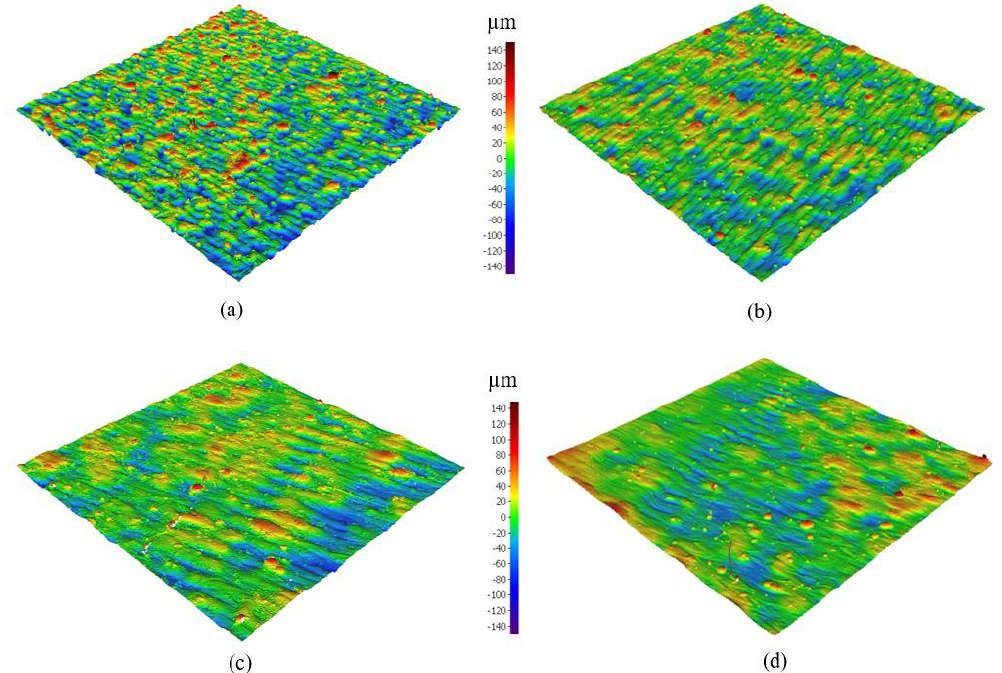
Figure 9. The 3D surface texture of the as-built AlSi10Mg samples; ( a ) AS8, ( b ) AS6, ( c ) AS3, and ( d ) AS1.